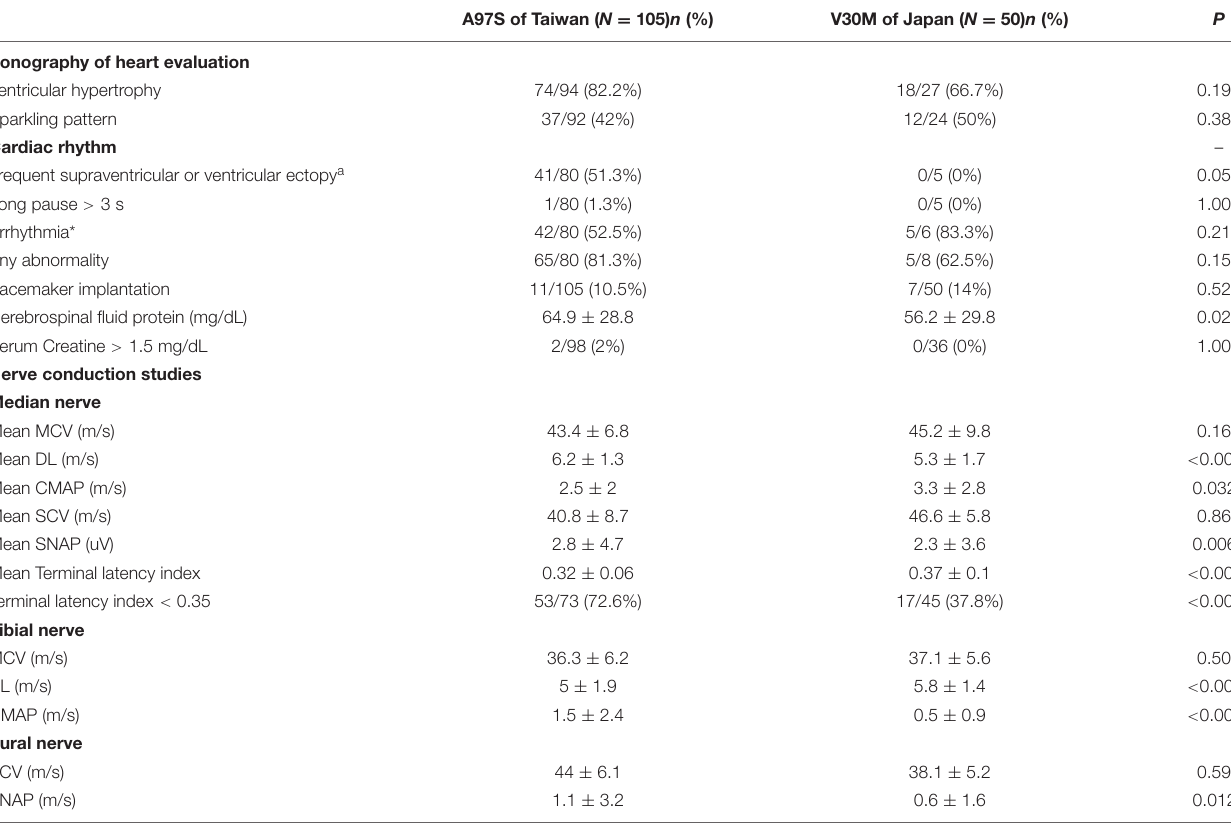
TABLE 2 | Laboratory findings at